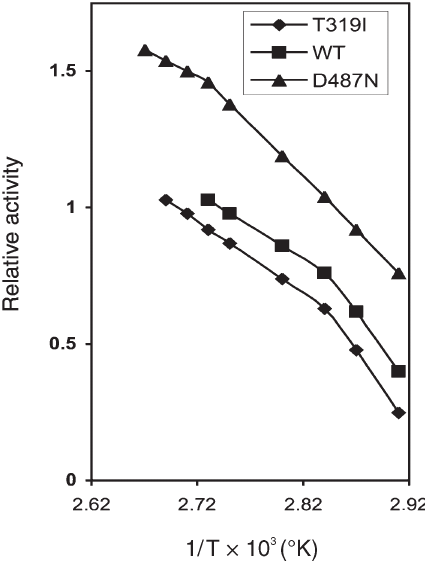
Figure 4. Arrhenius plot for Sulfolobus solfataricus recombinant WT amidase and its D487N and T319I mutants. Activities were measured at pH 5.0 with the standard assay. WT amidase ( (cid:2) ), T319I ( (cid:3) ) and D487N ( (cid:4) )